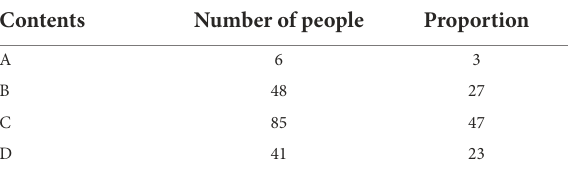
TABLE 3 Investigation on the structure of subjective symptoms of fatigue among